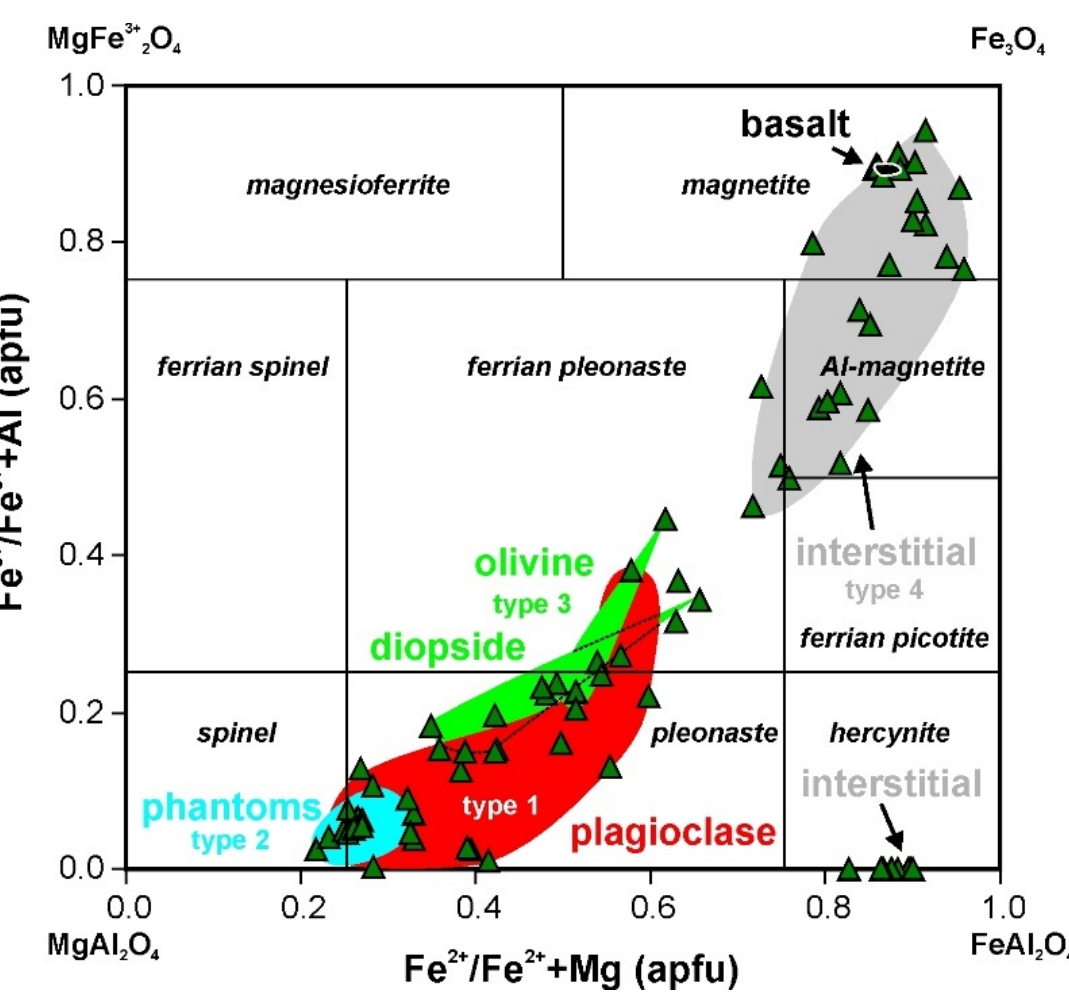
Figure 14. Classification diagram for the spinel group minerals form Č amovce, representing the lateral ‐ left face projection of the multicomponent prism defined by spinel, hercynite, chromite, magnesiochromite, magnesioferrite and magnetite endmembers [40]. Phase boundaries are from [41,42].